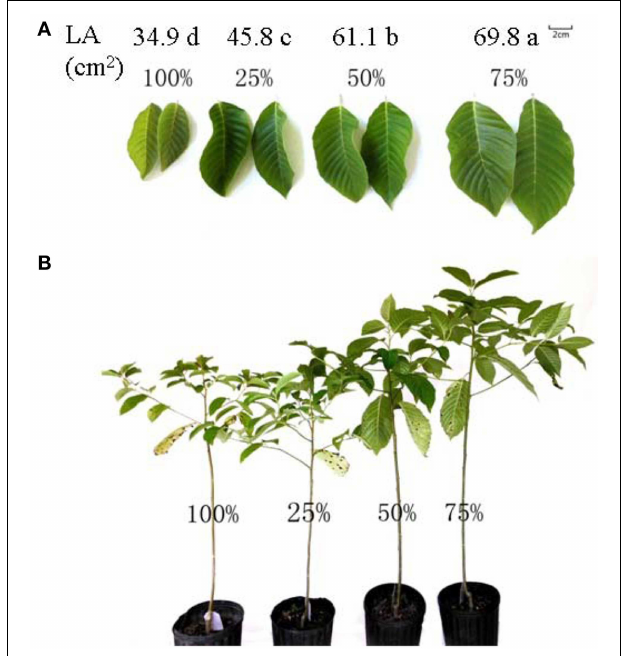
FIGURE 1 | C. acuminata leaves and leaf area (A) and seedlings (B). 100% level = 1500 ± 30 µ mol m − 2 s − 1